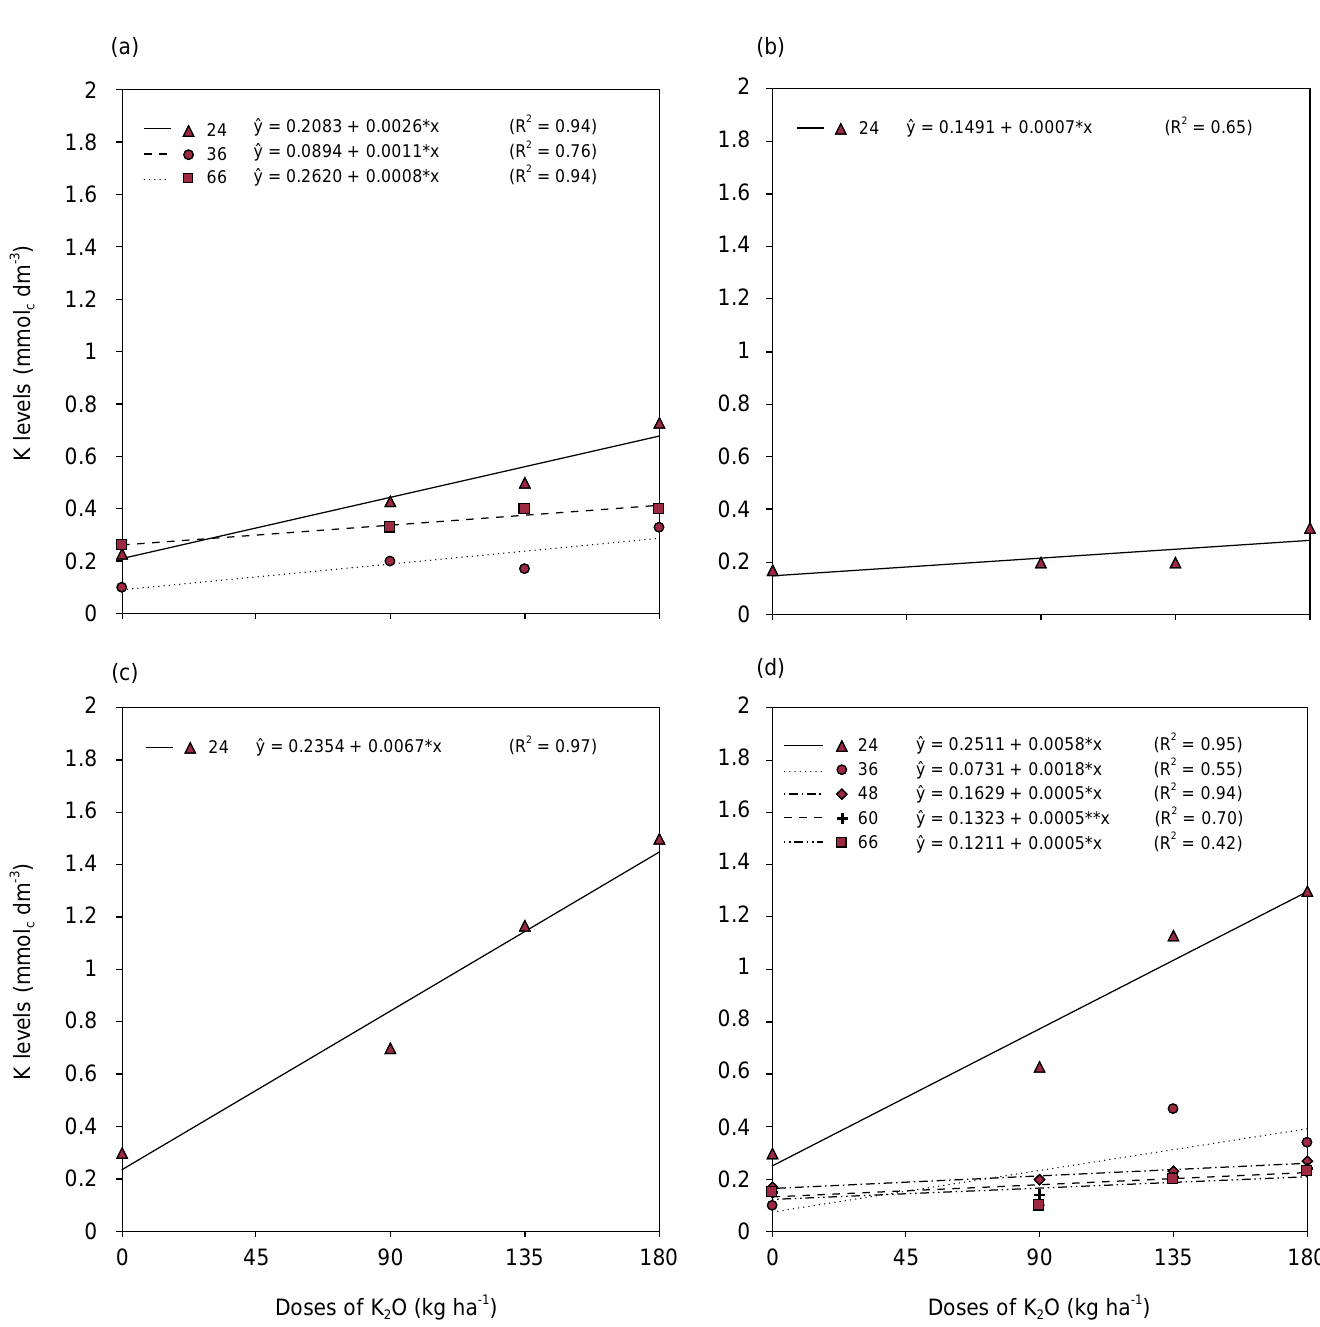
Figure 6. Potassium levels in the soil in the line (0.00-0.20 and 0.20-0.40 m) and interline (0.00-0.20 and 0.20-0.40 m) of the E. urophylla hybrid, evaluated at 24, 36, 48, 60, and 66 months after planting (respectively, a, b, c, and d), as a function of doses of K